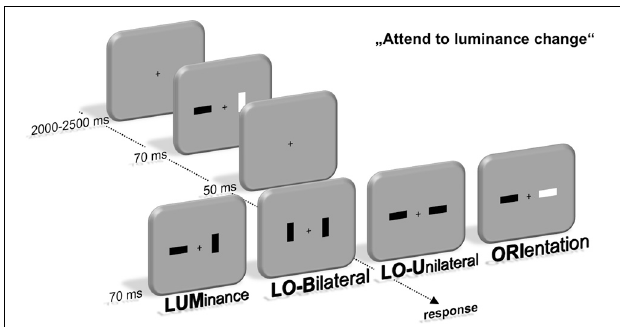
FIGURE 1 | Experimental setup. Participants were instructed to localize a change of luminance within a fast sequence of two stimulus displays containing two lateralized bars. These luminance changes either occurred alone (LUM) or simultaneous with an orientation change of the same (LOU) or contralateral bar (LOB). Additionally, only the orientation of one bar changed in one out of four trials (ORI). Localization was accomplished by a button press at the side of the luminance change using the index